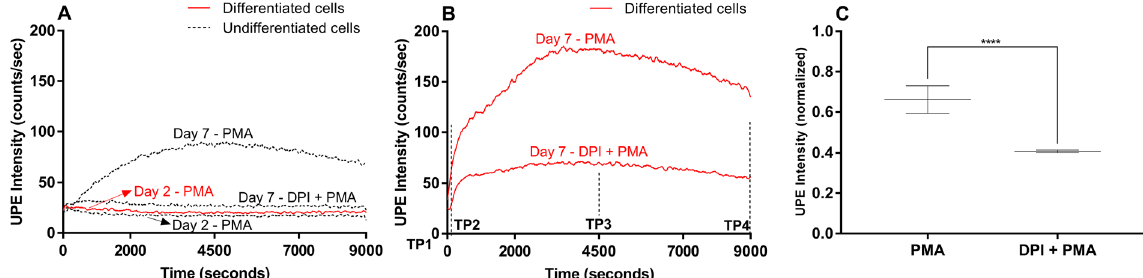
Figure 1. Dynamic UPE measurement of HL-60 cells treated with ATRA for 2 or 7 days to differentiate the cells into neutrophil-like cells. The lines (red - differentiated cells and black - undifferentiated cells) represent the moving UPE average of 100 points. (A) Control measurements. (B) The UPE profile of differentiated cells (day 7) was recorded after stimulation with PMA in the absence or presence of DPI. (C) Summary of peak UPE intensity measured in HL-60 cell treated for 7 days with ATRA after stimulation with PMA in the absence or presence of DPI. The data are represented as the mean ± SD (n = 5) of the normalized maximum peak intensity. Student’s paired t -test with **** p <